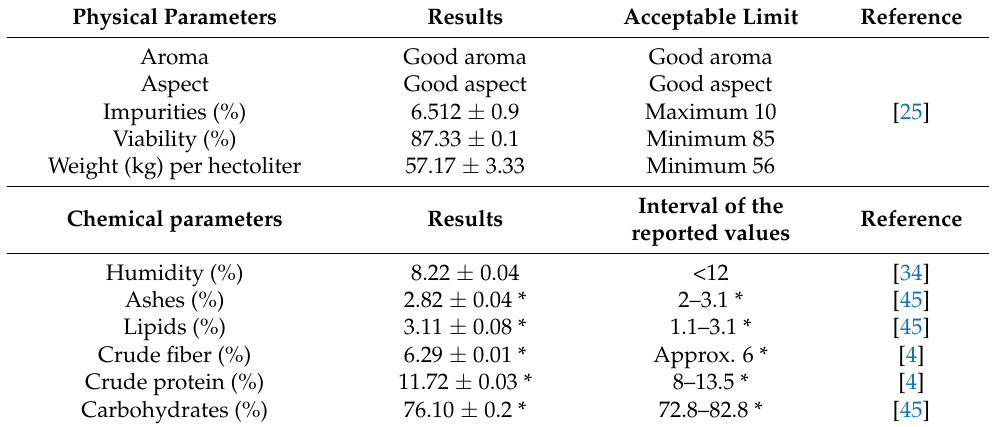
Table 1. Physicochemical characteristics of the barley